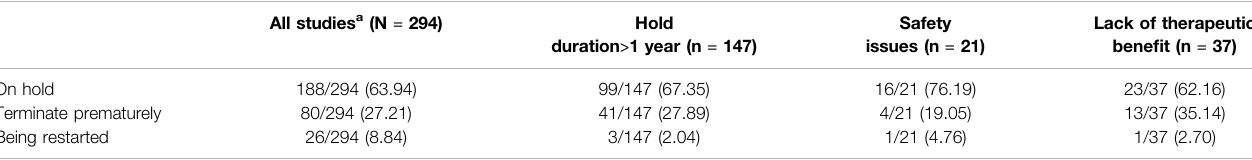
TABLE 4 | Analysis of outcomes of suspensions of clinical trials.